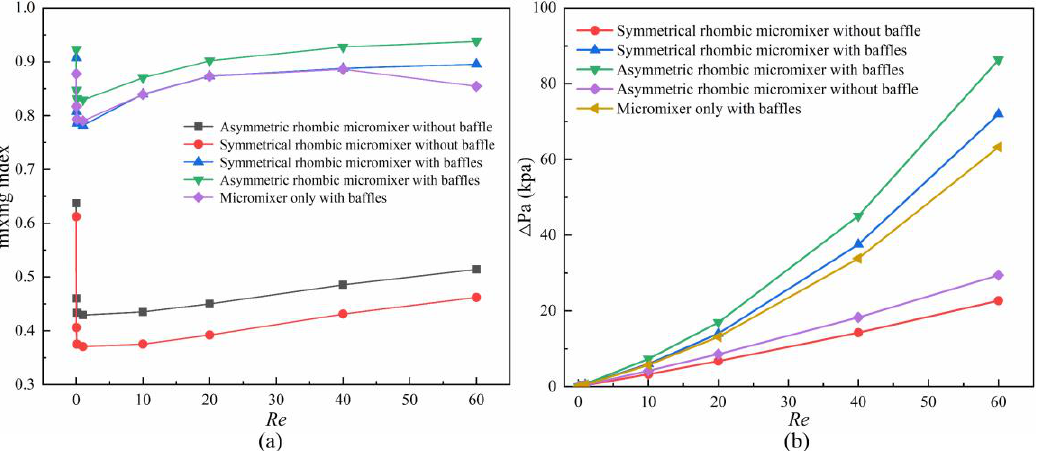
Figure 10. Comparison of five rhombic mixers. ( a ) Mixing index curves; ( b ) Pressure drop curves.